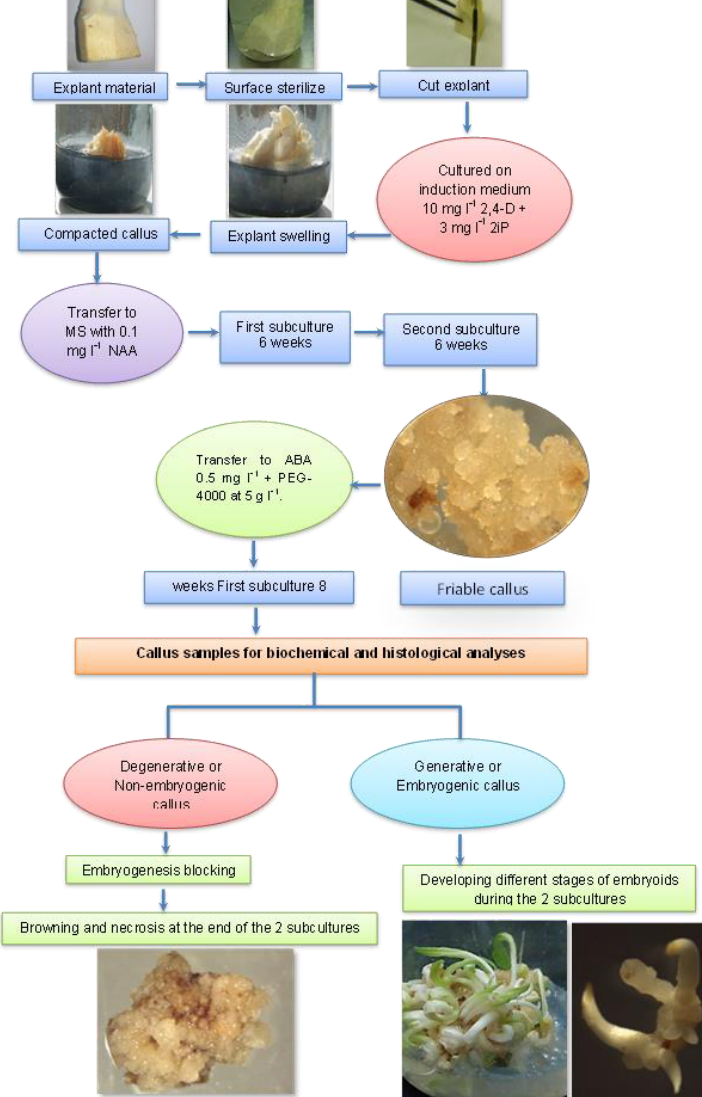
Figure 1. A scheme illustrating the experimental layout .